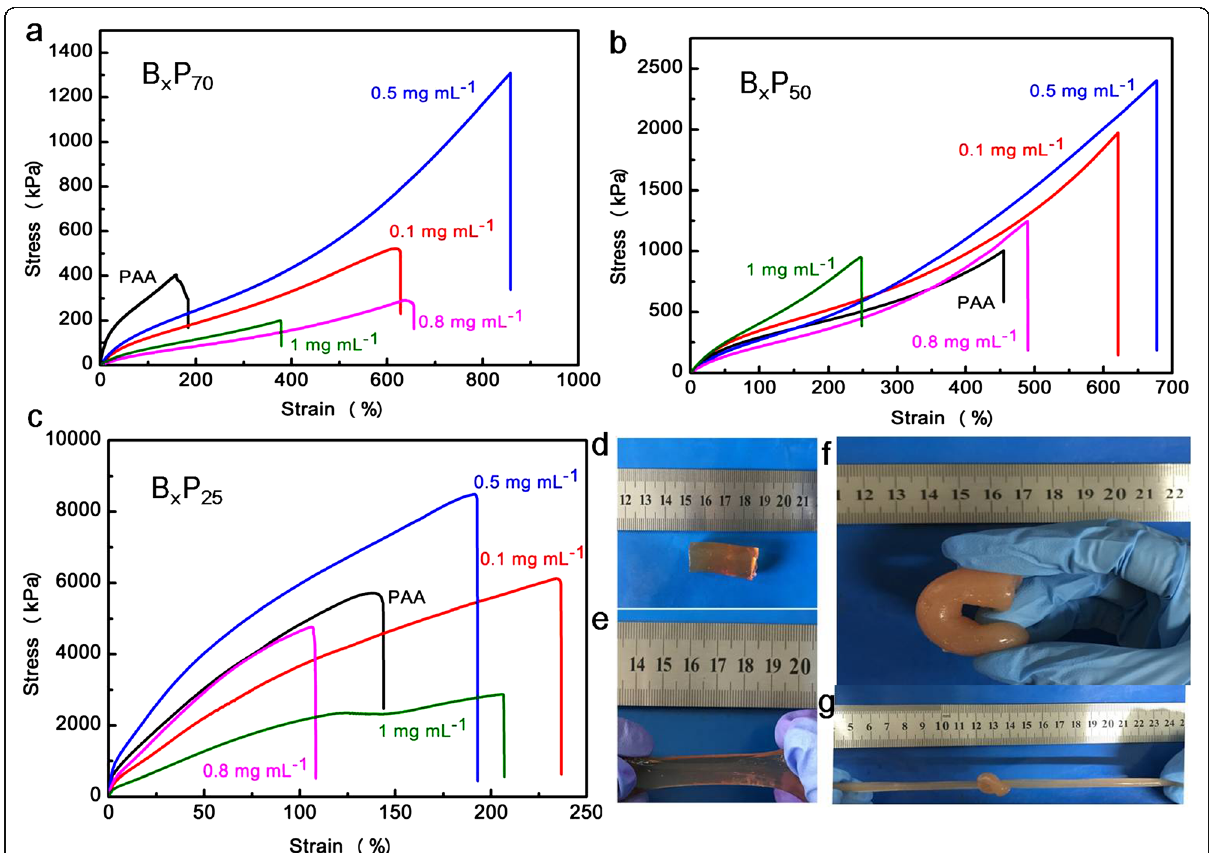
Fig. 3 Tensile stress-strain curves of the composite hydrogels: a B x P 70 , b B x P 50 , and c B x P 25 . The digital photograph of composite hydrogels: d original, e stretched, f bent, and g stretched after being